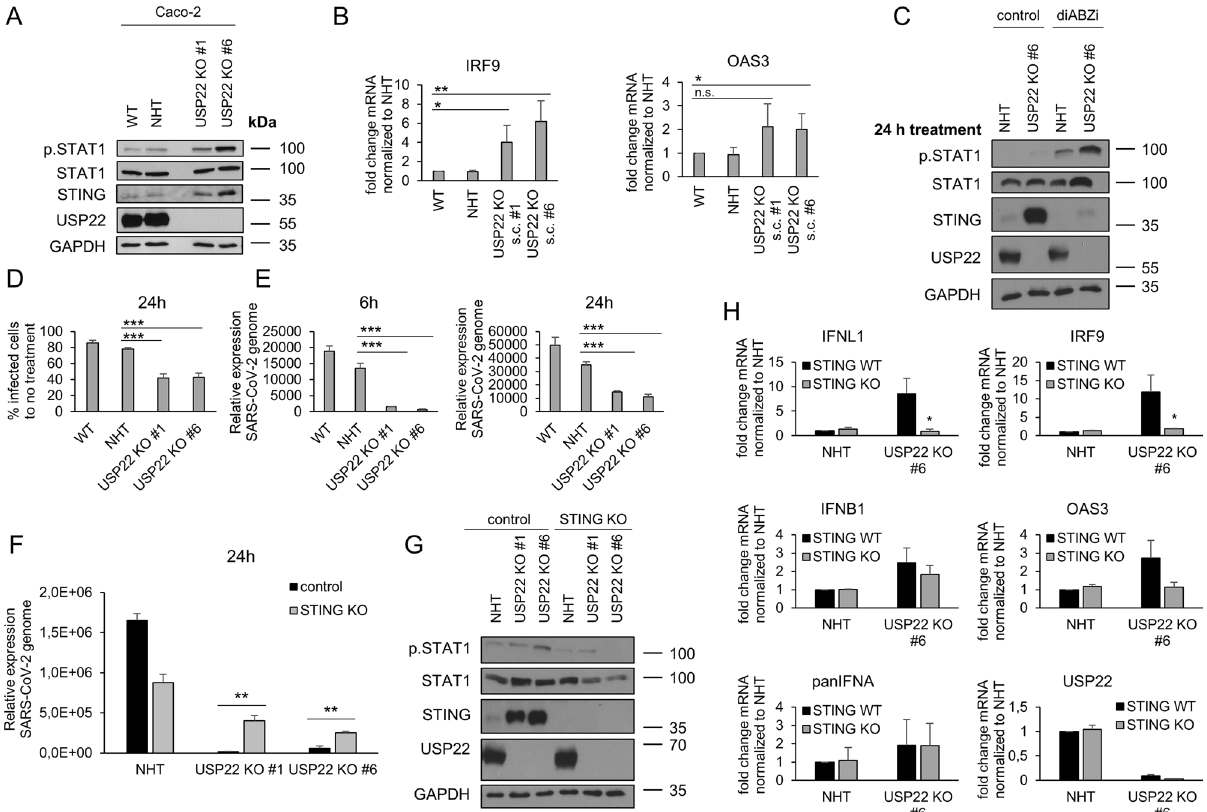
Fig. 6 Loss of USP22 protects against SARS-CoV-2 infection, replication and de novo infectious virus production in a STING-dependent manner. A Western blot analysis of phosphorylated and total STAT1, STING, and USP22 expression levels in WT, control (NHT), and two CRISPR/Cas9-generated USP22 KO Caco-2 single clones (USP22 KO #1 and #6). GAPDH served as loading control. Representative blots of at least two different independent experiments are shown. B Basal mRNA expression levels of IRF9 and OAS3 in WT, control, and USP22 KO Caco- 2 cells (USP22 KO #1 and #6). Gene expression was normalized against 28 S mRNA and is presented as x-fold mRNA expression compared to NHT. Mean and SD of three independent experiments in triplicate are shown. * P < 0.05; ** P < 0.01, n.s. not signi fi cant. C Western blot analysis of phosphorylated and total STAT1 and total STING expression levels after 24 h of treatment with 1 µM STING agonist diABZI in control and USP22 KO Caco-2 cells (USP22 KO #6). GAPDH served as loading control. Representative blots of at least two different independent experiments are shown. D Quanti fi cation of immuno fl uorescence-stained SARS-CoV-2-infected cells, normalized against non-infected cells. WT, control, and USP22 KO Caco-2 cells (USP22 KO #1 and #6) were stained with anti-dsRNA (J2) at 24 hpi. Mean and SD of three independent experiments in triplicate are shown. *** P < 0.001. E Quanti fi cation of relative SARS-CoV-2 genome expression of SARS-CoV-2-infected WT, control and USP22 KO Caco-2 cells (USP22 KO #1 and #6) at 6 hpi (left) and 24 hpi (right). Data are normalized against non-infected cells. Mean and SD of three independent experiments in triplicate are shown. *** P < 0.001. F Quanti fi cation of relative SARS-CoV-2 genome expression of SARS-CoV-2-infected control-NHT, control-USP22 KO #1 and #6, STING KO-NHT and STING-USP22 dKO (USP22 KO #1 and #6) Caco-2 cells at 24 hpi. Mean and SD of three independent experiments in triplicate are shown. ** P < 0.005. G Western blot analysis of total and phosphorylated STAT1, total STING and USP22 expression levels in control-NHT, control-USP22 KO #1 and #6, STING KO-NHT and STING-USP22 dKO (USP22 KO #1 and #6) Caco-2 cells. GAPDH served as loading control. Representative blots of at least two different independent experiments are shown. H Basal mRNA expression levels of IFNL1, IFNB1 and panIFNA, and ISGs IRF9 and OAS3 as well as USP22 in control and USP22 KO Caco-2